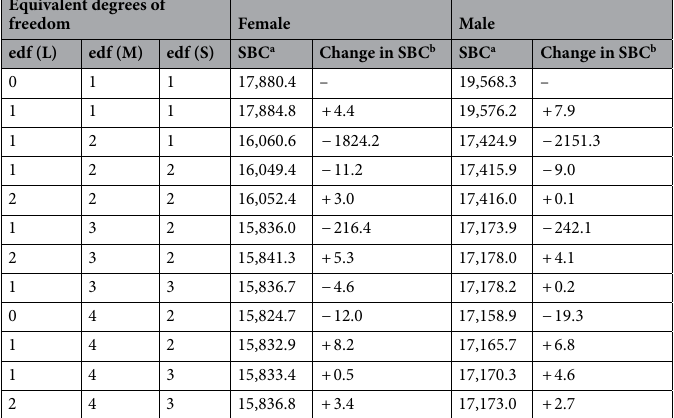
LMS parameters. Table 1 shows the different combinations of edf values chosen for the modelling and optimization process of the new calculated percentile curves. The edf values were increased and reduced one at a time until the smallest SBC value was found. First, we set the initial edf values for L to 0 and for M and S to 1. Considering edf (M) > edf (S) > edf (L), edf values for M were increased first, followed by edf values for S. While higher edf values for M and S generated smaller SBC values, greater edf values for L produced higher SBC values (Table 1). For both genders, the best model optimization was achieved with edf values of L = 0, M = 4, and S = 2, as they provided the highest reduction in SBC and a reasonable smoothing. As seen in Table 1, a subsequent increase in edf values did not lead to a reduction in SBC values. Tables 2 and 3 show the LMS parameters for axial length. In both females and males, value of 1 was used to represent the L curve at all ages. M curve increased with age in both genders. On average, males presented higher but not significantly different than females (average difference = 0.54 ± 0.04 mm; p = 0.10, t-value = − 1.75, df = 18; two-sample t-test). S curve increased with age in both genders, reaching the highest values at age 15. Both groups showed similar S curves (p = 0.81, t-value = 0.24, df = 18; two-sample t-test). Percentile growth curves derived from LMS parameters. Figure 1a and Table 2 exhibit the new percentile growth curves for axial length generated using the LMS parameters. In both genders, all percentiles trended upward with age. The higher the percentile rank, the greater the increase in axial length. From 6 to 15 years, the 2nd percentile had a total axial elongation of 1.59 mm (females) and 1.71 mm (males), while the 98th increased by 2.35 mm (females) and 2.46 mm (males). Concretely, in the female group, the 10th percentile